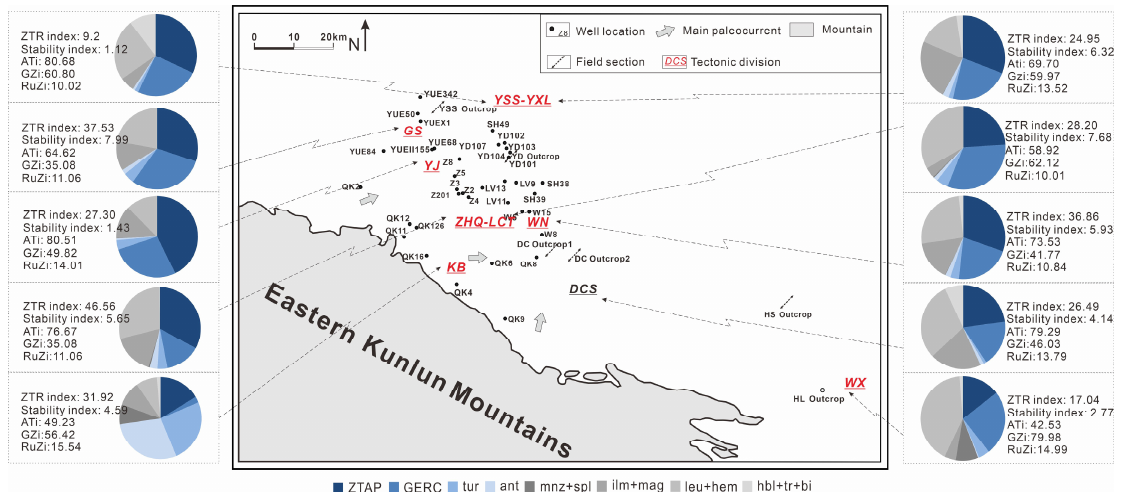
Figure 8. The proportions of ZTAP, GERC mineral assemblages, and other heavy mineral ratios in different areas.